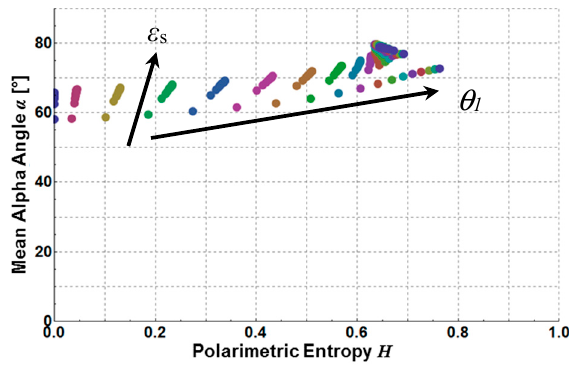
Figure 14. Sensitivity of polarimetric H – α scattering plane with roughness angle θ 1 ( ε s = (2,42), ε t = 10, L SXD = 1, ϕ = 0°, ω 1 = 35°). Color changes with increasing θ 1 .